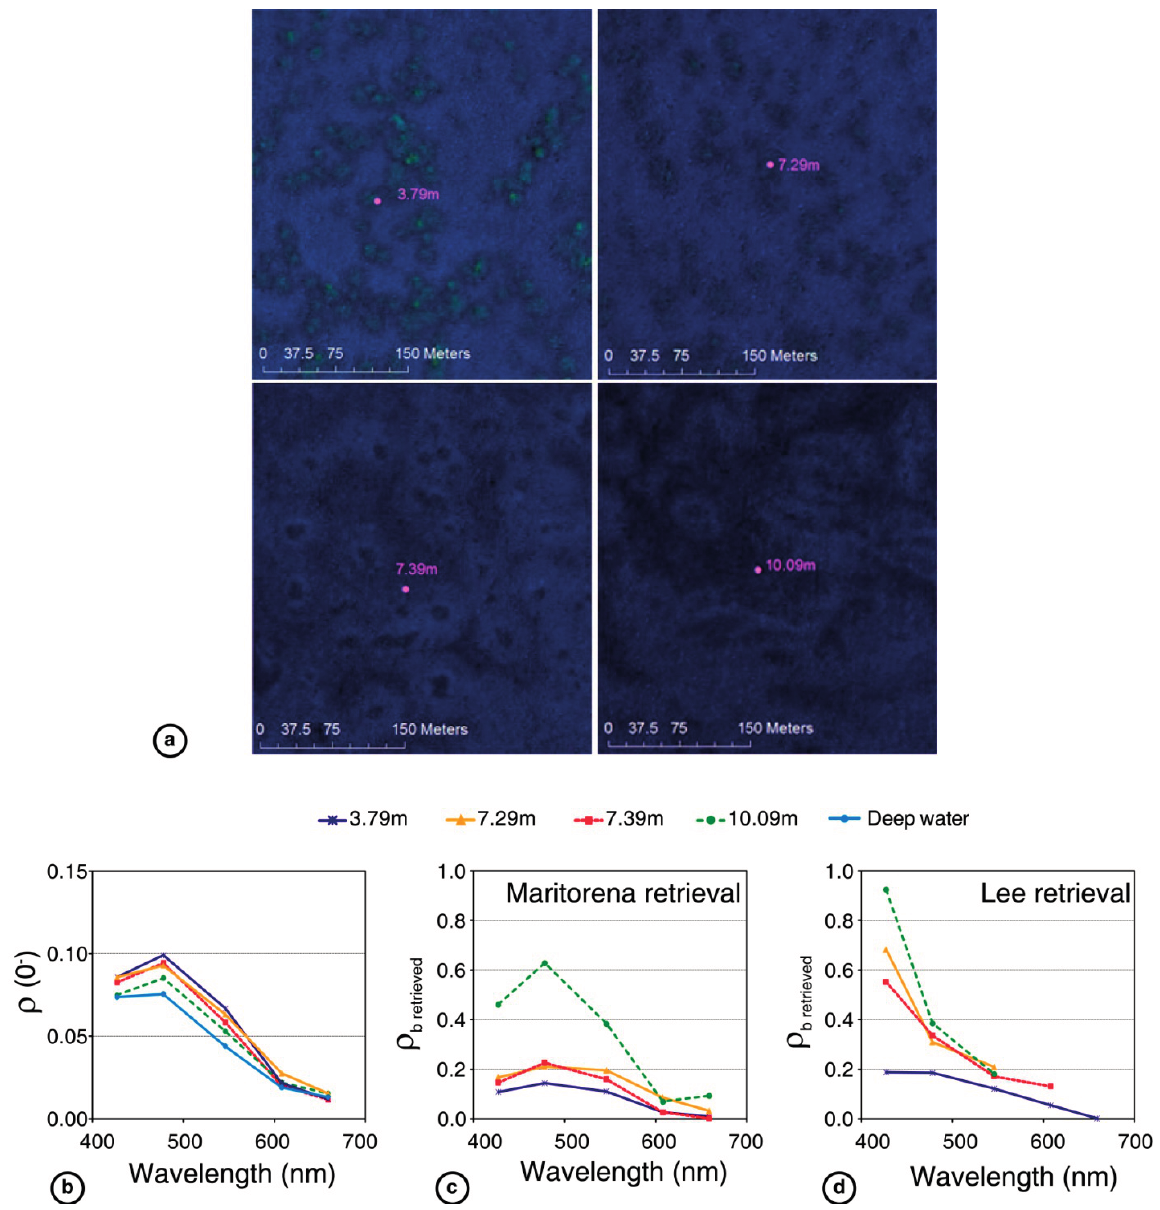
Figure 12. ( a ) Zoom in different portions of WV02 image in quasi-true color (R: 659 nm; G: 546 nm; B: 478 nm). All images have exactly the same contrast and are in the same scale. Pink circles show location of depth points and their values are indicated; ( b ) Reflectance below water versus wavelength (nm) captured by WV02 sensor above the four points located in (a) and above deep water; ( c , d ) Bottom reflectance below water versus wavelength (nm) retrieved by M94 and L99,